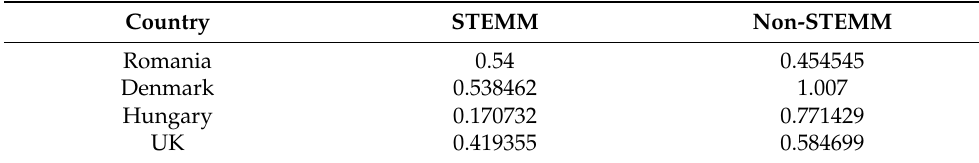
Table 2. Ratios of women in STEMM/non-STEMM departments in each country.